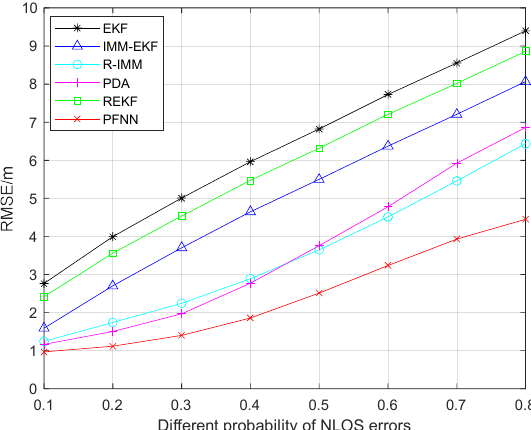
Figure 9. The RMSE versus the probability of the NLOS error. Table 4. Total computational time.